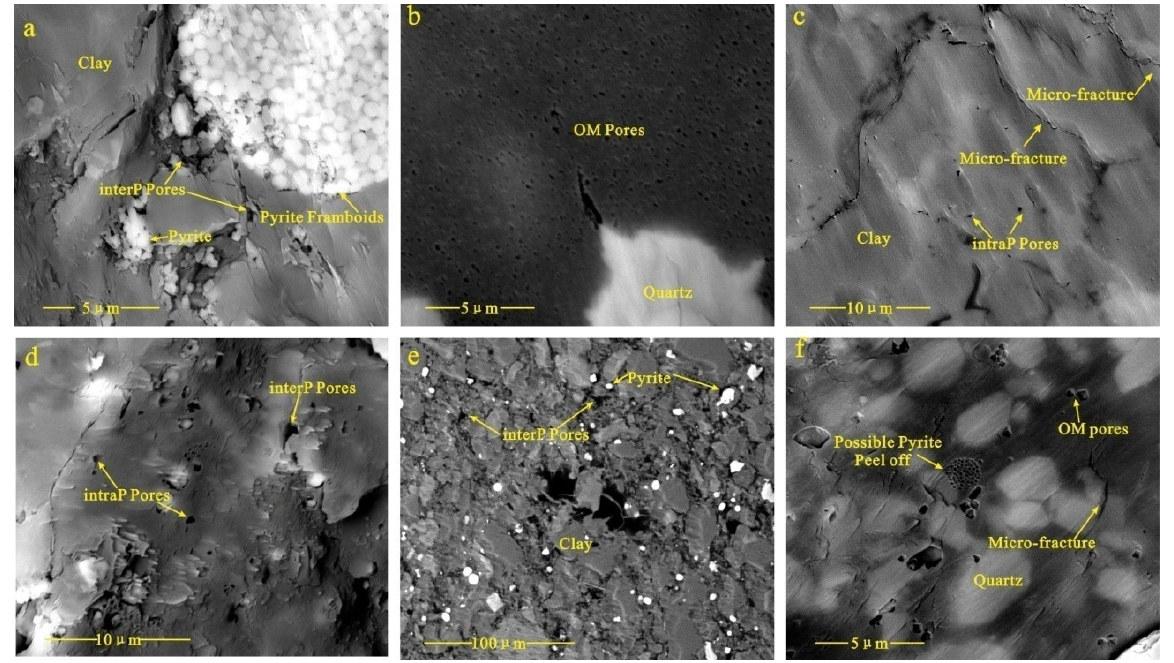
Figure 5: Pore distribution of different types of nanoscale organic matter in shale (a: intragranular pores developed in strawberry-like pyrite and clay minerals, F-1, R o = 2.10%; b: honeycomb organic pores, F-2, Ro = 2.35%; c: intragranular pores and microcracks, F-3, Ro = 2.51%; d: intergranular pores and intragranular pores, F-4, Ro = 2.51%; e: clay mineral grains Inter-hole, F-8, Ro = 3.41%; f: micro-crack and organic pore, F-9, Ro =